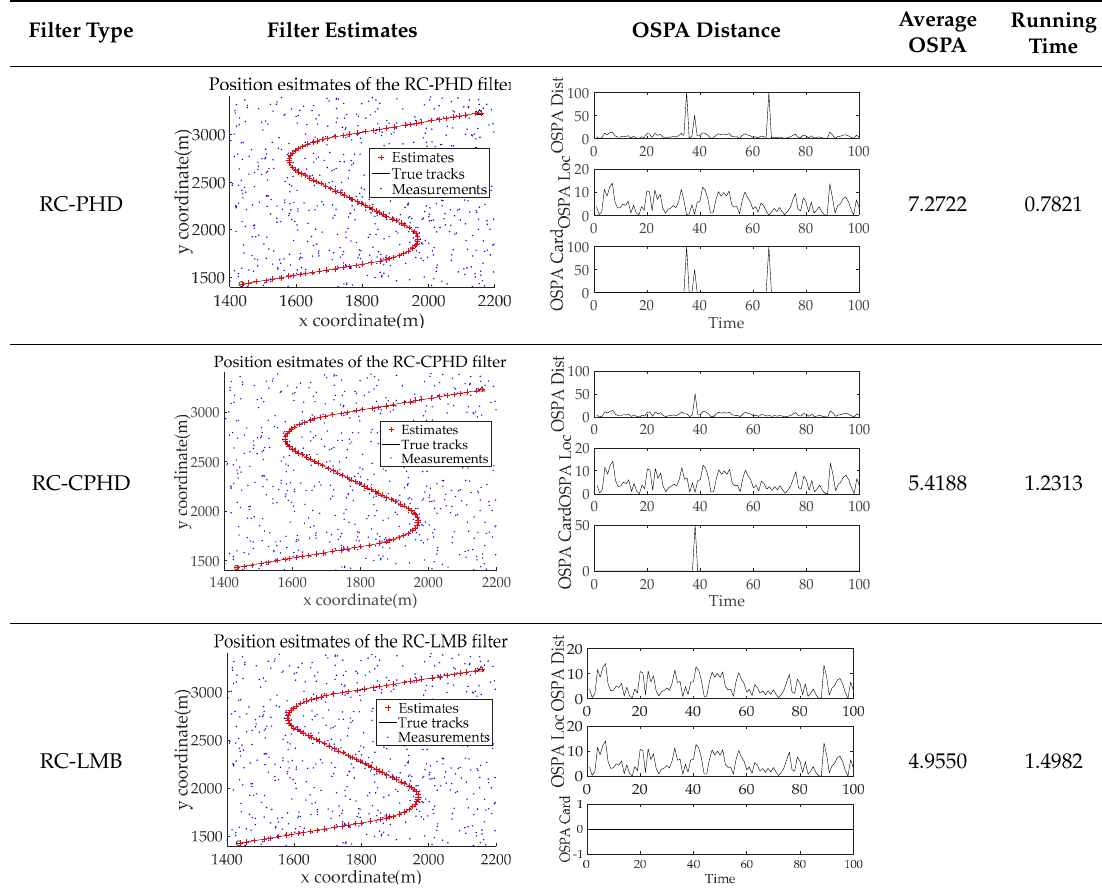
Table 7. Filtering performance comparison of three filters.